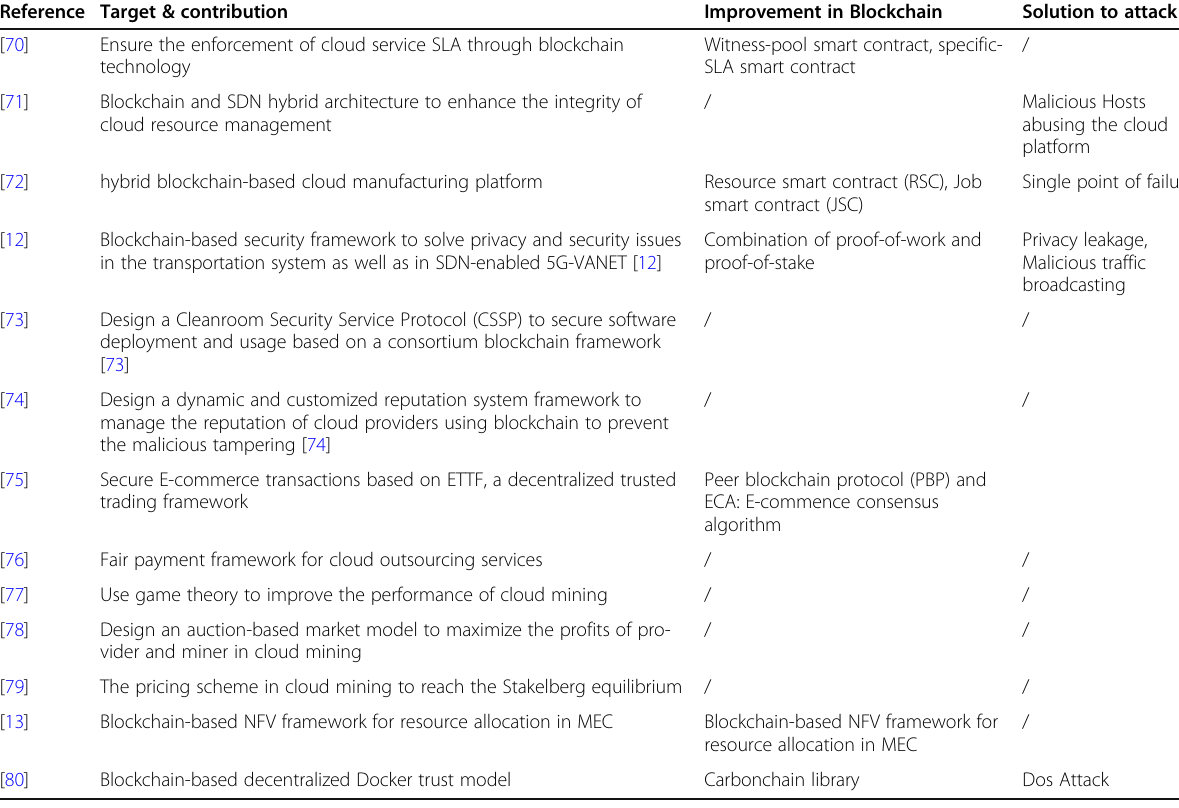
Table 6 Comparison of main contributions